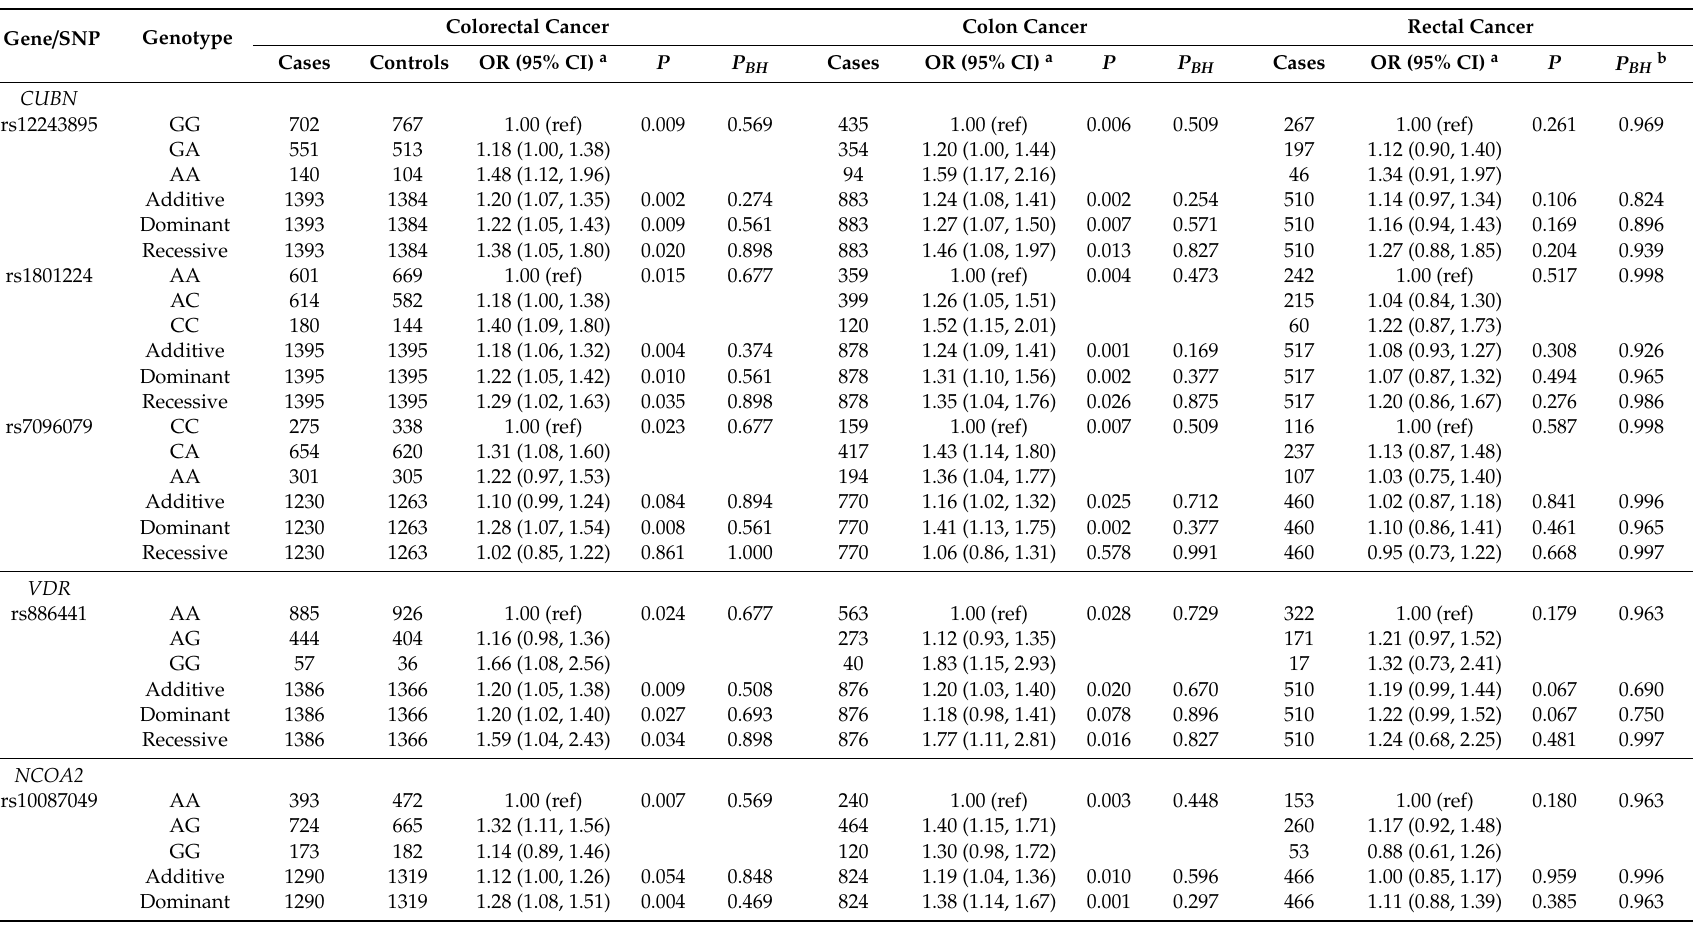
Table 3. Associations of SNPs with CRC risk overall and by tumor location (colon vs. rectum), the EPIC study,